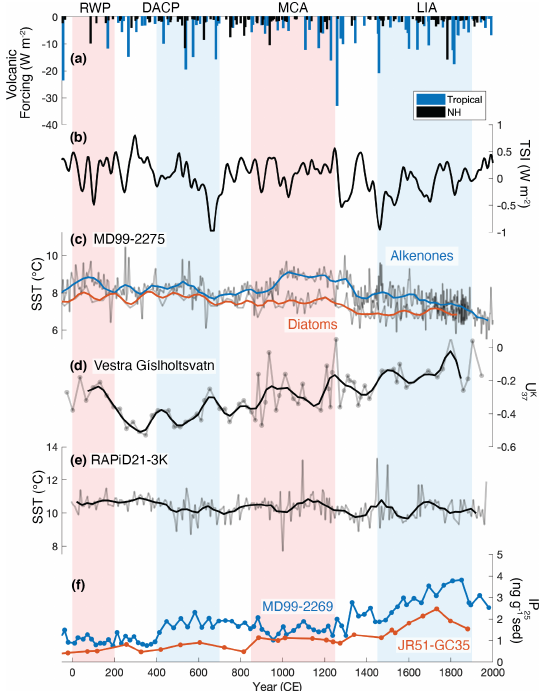
Figure 7. Major changes in radiative forcings over the past 2000 years are shown, including (a) volcanic forcing from tropi- cal and NH eruptions (Sigl et al., 2015) and (b) changes in total solar irradiance (TSI; Steinhilber et al., 2009). Marine and terres- trial reconstructions from Iceland are shown, including (c) alkenone and diatom sea surface temperature (SST) reconstructions from core MD99-2275 on the north Icelandic shelf (Sicre et al., 2008; Jiang et al., 2015), (d) an alkenone winter–spring temperature reconstruc- tion from VGHV in southwest Iceland (this study), (e) an alkenone SST record from core RAPiD21-3K in the subpolar North Atlantic (Sicre et al., 2011), and (f) sea ice reconstructions developed us- ing IP 25 from cores MD99-2269 (blue) and JR51-GC35 (orange) from the north Icelandic shelf (Cabedo-Sanz et al., 2016). The tim- ing of major climate anomalies inferred from Icelandic climate records include the Roman Warm Period (RWP, ca. 0–200CE), Dark Ages Cold Period (DACP, ca. 400–700CE), Medieval Climate Anomaly (MCA, ca. 850–1250CE), and Little Ice Age (LIA, ca.